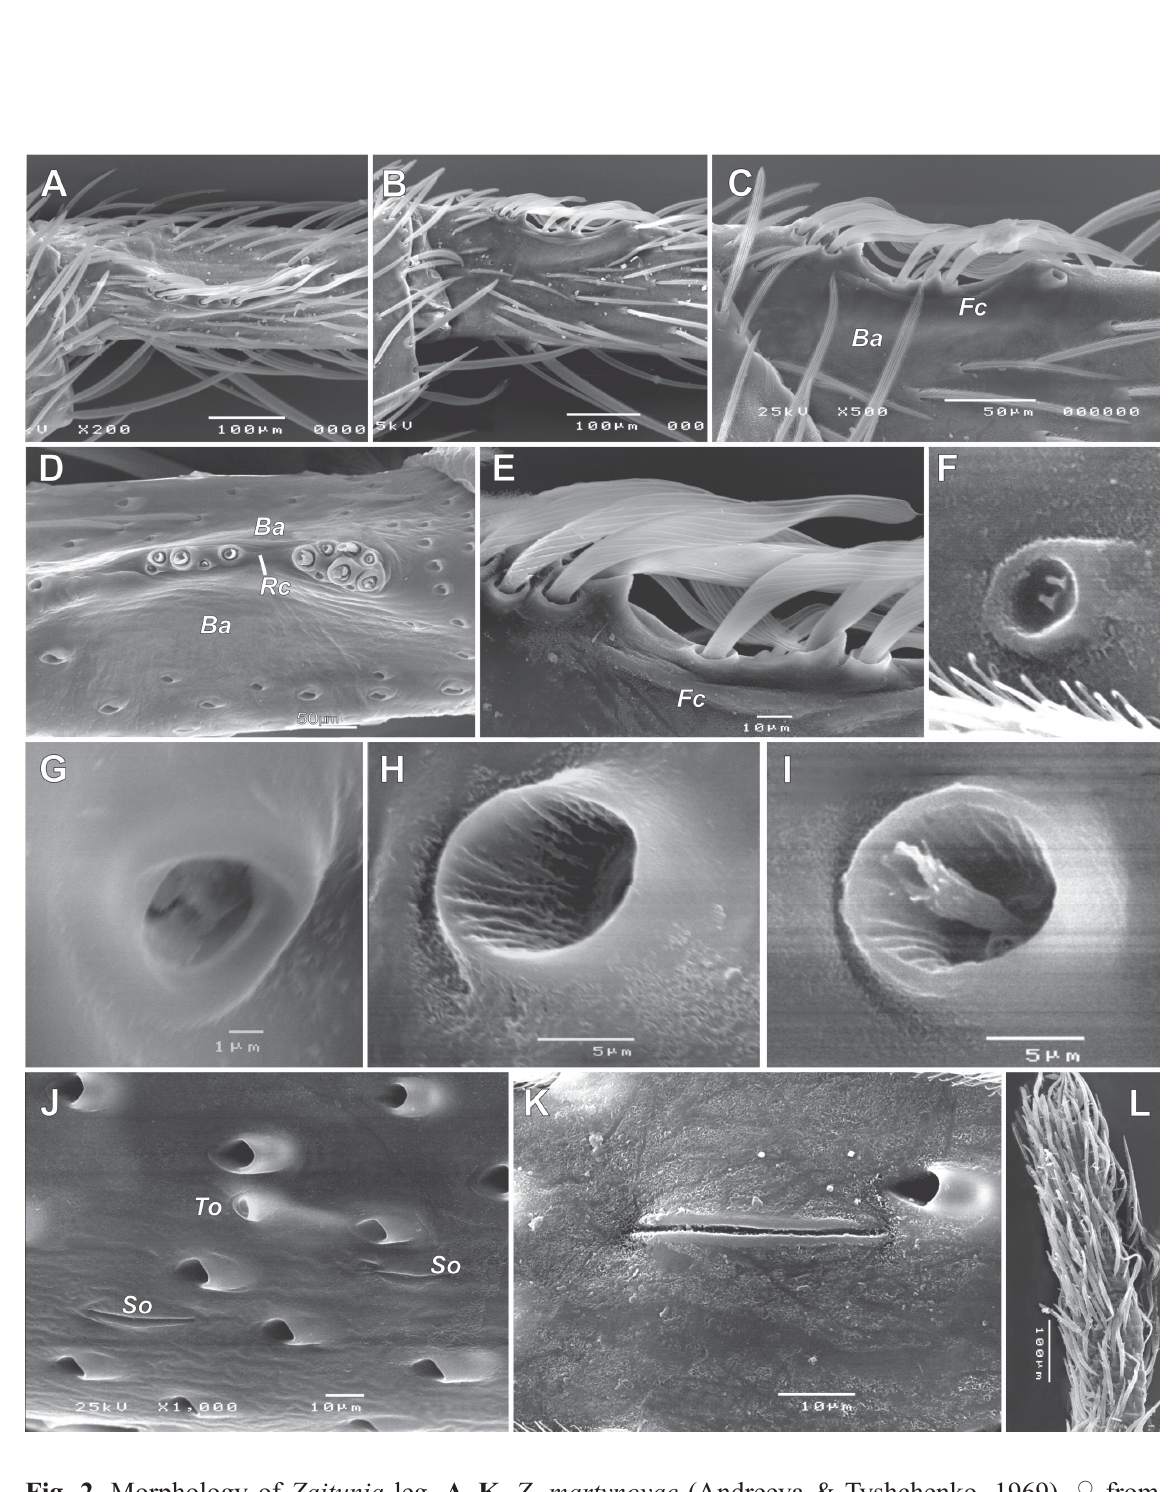
Fig. 2. Morphology of Zaitunia leg. A – K . Z . martynovae (Andreeva & Tyshchenko, 1969), ♀ from Gandzhina. L . Z. logunovi sp. nov., paratype, ♂. — A . Calamistrum, dorsal. B–C . Same, lateral. D . Calamistral area with removed setae, dorsal. E . Setae of calamistrum, lateral. F–G . tarsal organ. H–I . Base of trichobothria. J . Part of dorsal leg surface showing two slit organs. K . Long slit organ. L . Part of male tarsus iV, prolateral, showing pseudosegmentation. abbreviations: see Material and